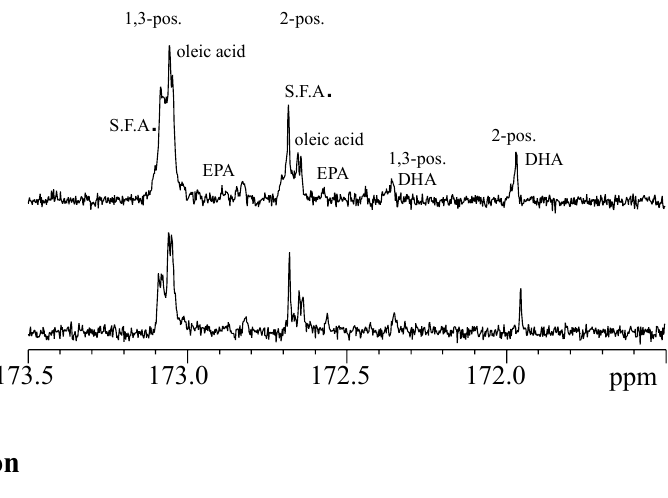
Figure 3. Expansions of 13 C-NMR spectra of Sparus aurata lipid fractions relative to the carbonyl carbons region. 1,3-pos. and 2-pos. are referred to the position of esterified fatty acids on glycerol.(Top: intensive; bottom: semi-intensive; S. F.A.: saturated fatty acids).